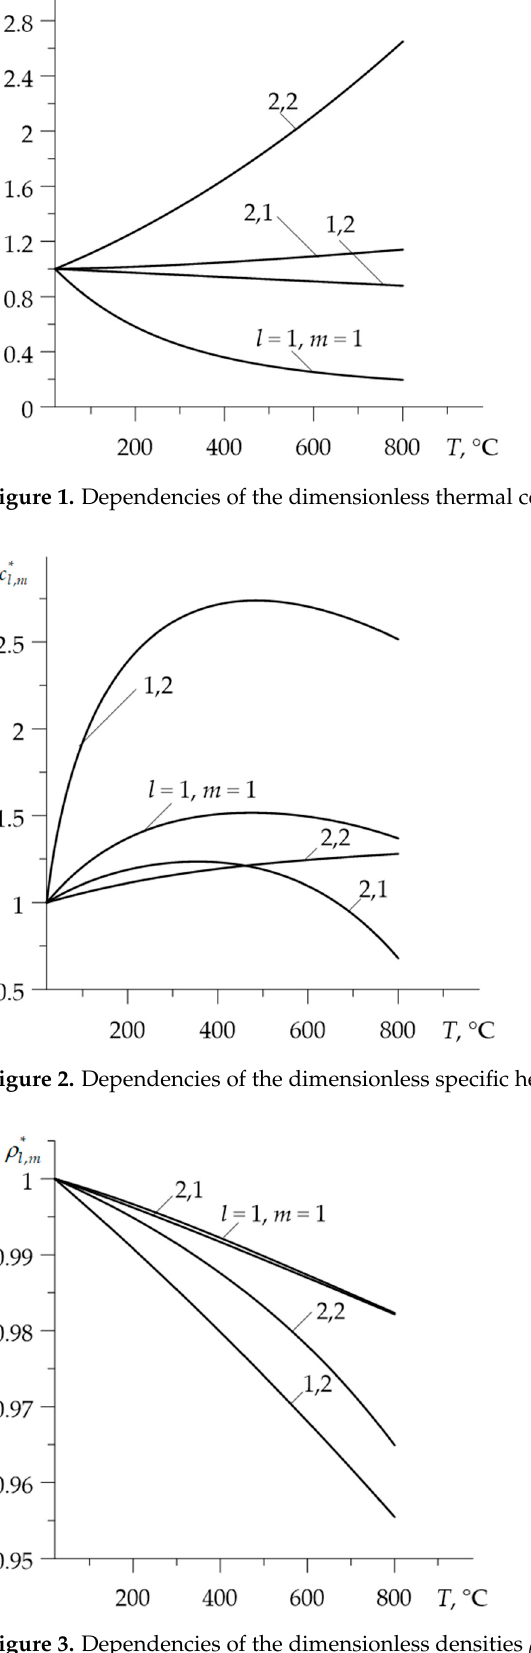
Figure 3. Dependencies of the dimensionless densities ∗